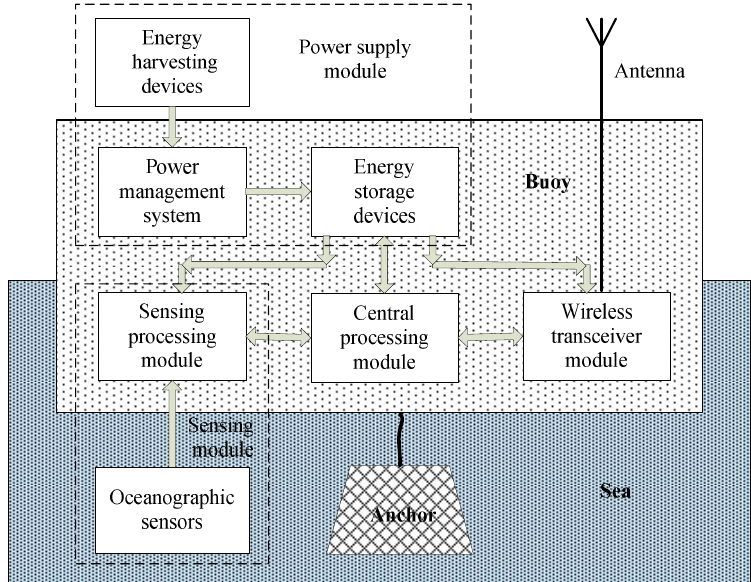
Figure 4. General architecture of a marine environment monitoring sensor node.